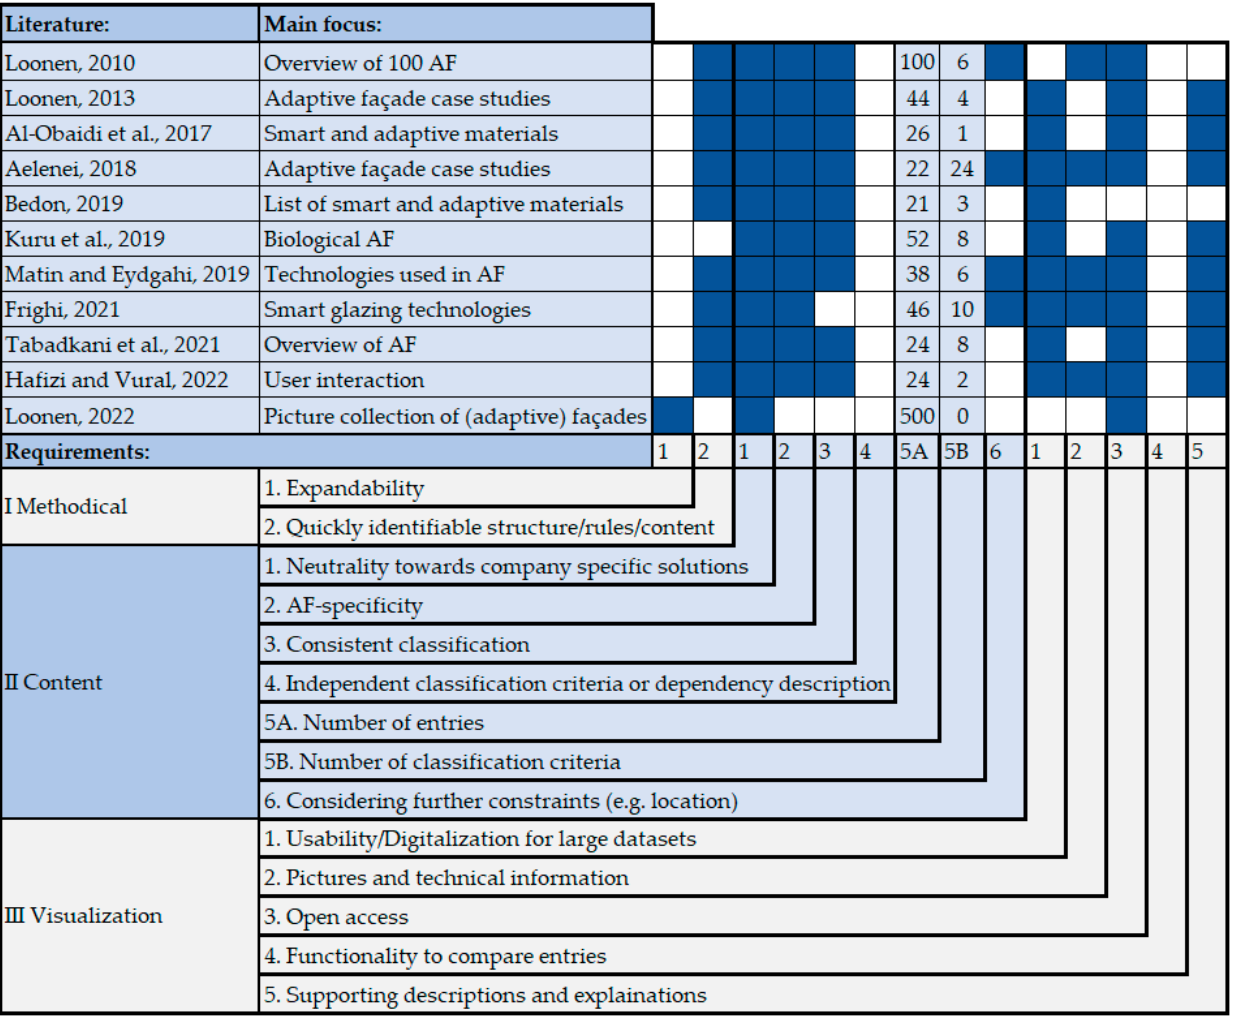
Figure 5. Evaluation of the existing adaptive façade solution collections [22,45–54] and identification of research gaps.